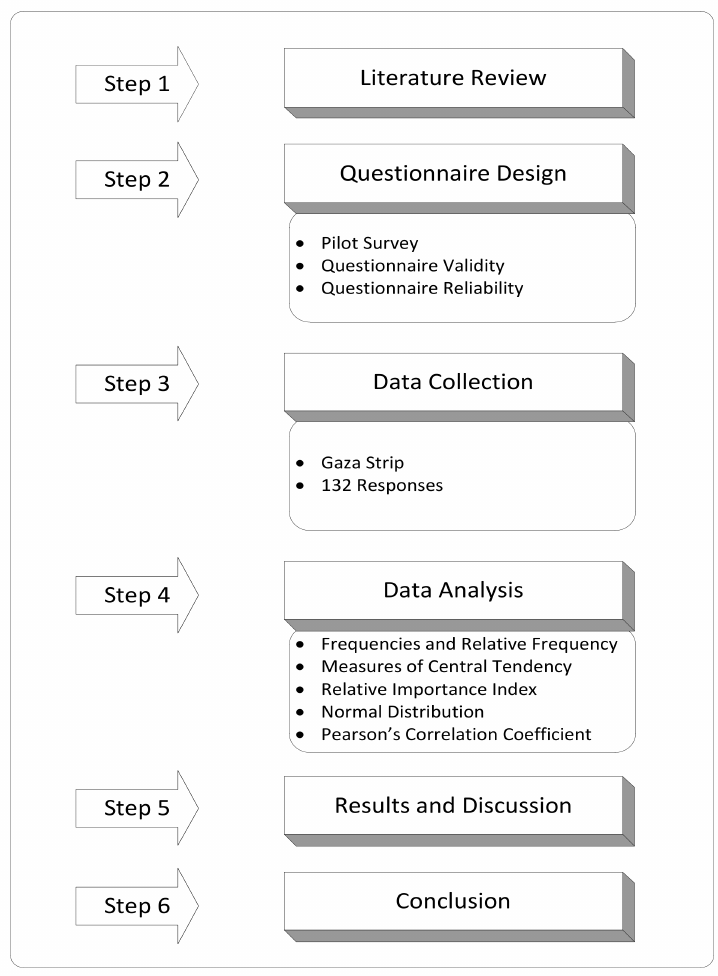
Figure 2. Research